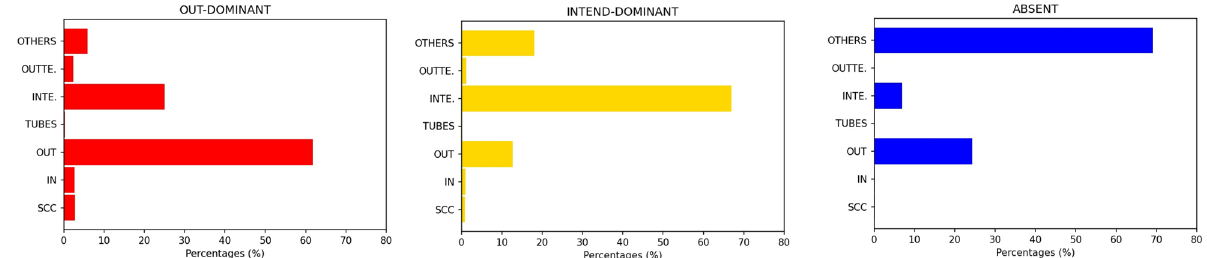
Figure 10. Percentages of social-bots in each sector of the bow-tie structure for OUT-dominant, INTEND- dominant and not informative bow-ties. This figure collects the percentage of bots in every bow-tie’s sector for discursive communities with OUT-dominant, INTEND-dominant and not informative bow-tie structure. It is easy to note how the highest percentages can be found in the OUT sector, in the INTENDRILS and in the OTHERS one, respectively for the case of OUT-dominant, INTEND-dominant and not informative